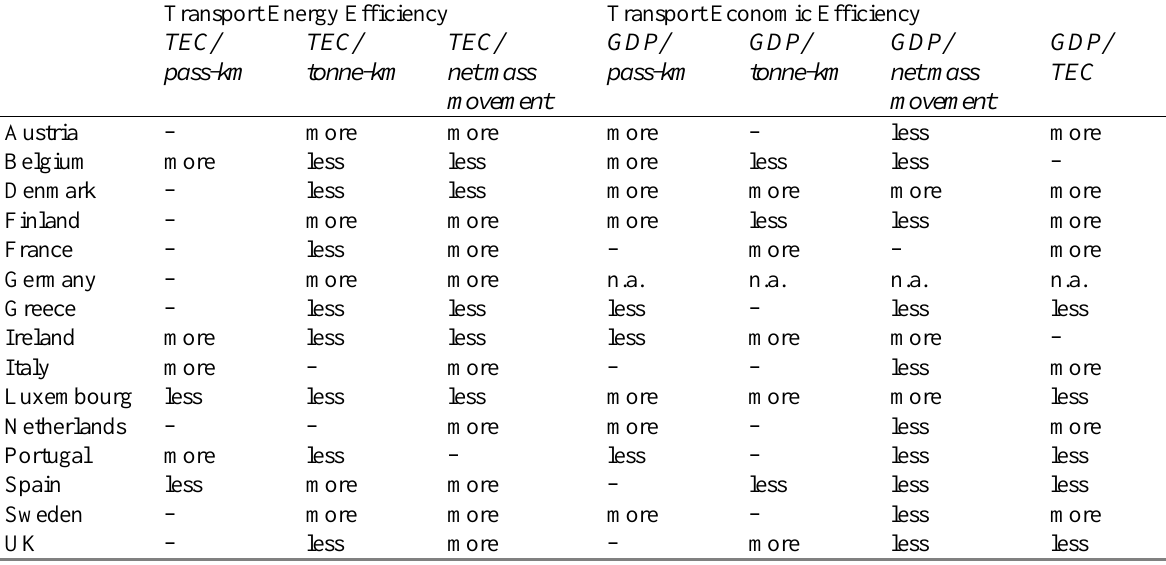
Table 4. Summary of Transport Intensity Measures in Europe relative to the EU average (1995